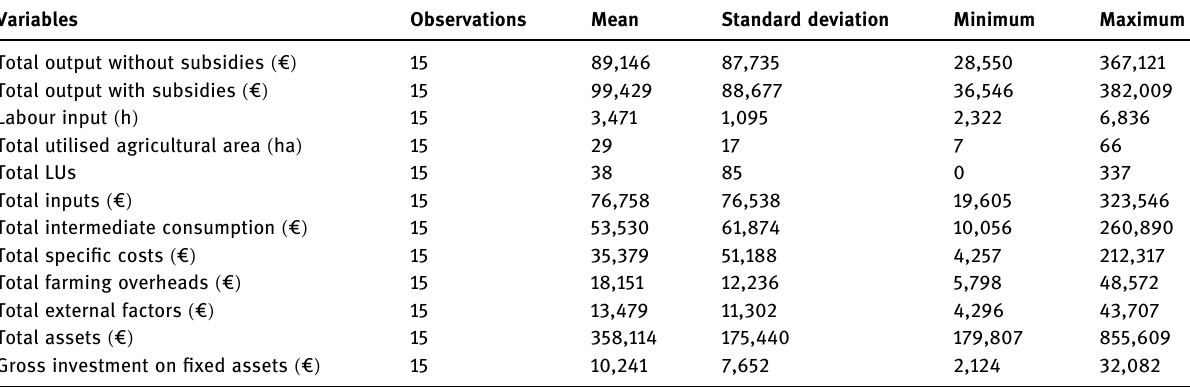
Table 2: Statistical summary of several variables considered ( data on average for the period 2014 – 2018 )